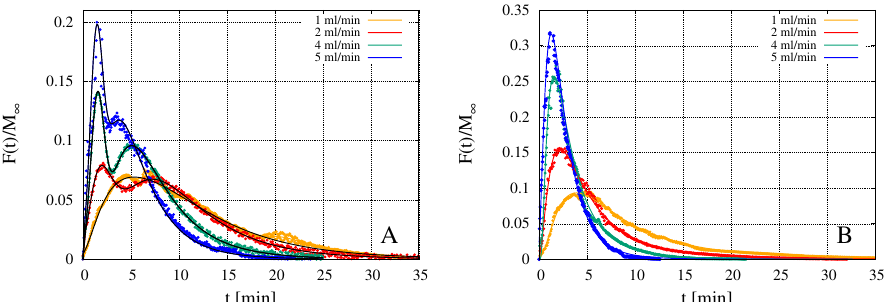
Figure 9. Rescaled differential release curves F ( t ) / M ∞ vs. time t [min] of fluconazole in MFTD. ( A ) GG-2%Gly films loaded with the complex Flu/HP- β -CD. ( B ) GG-6%Gly films loaded with not complexed fluconazole. Continuous black lines in Figure A show the best-fitted bimodal function, Equation